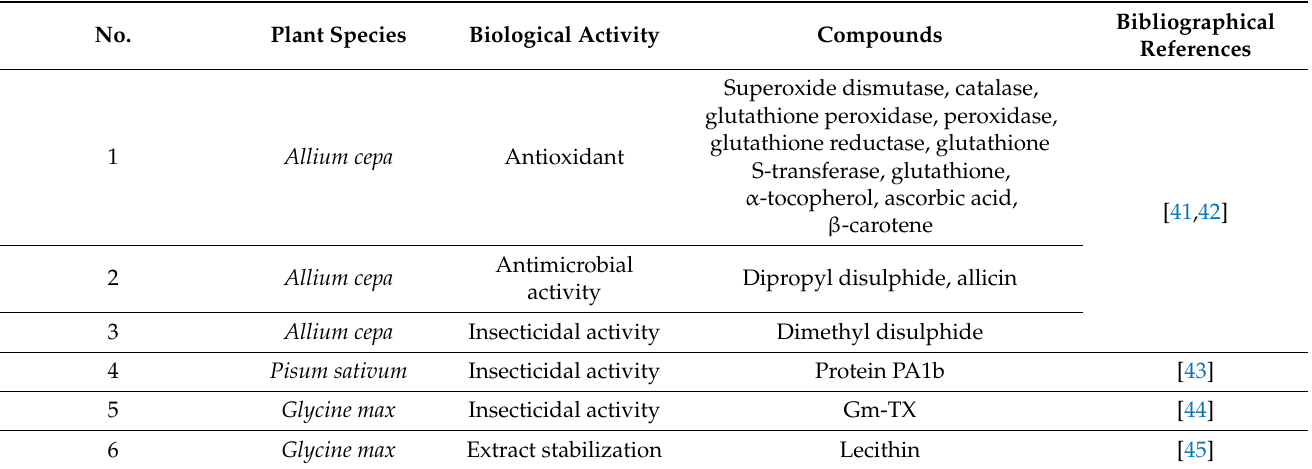
Table 1. The most important bioactive substances with a role in biostimulation, fertilization, and repellent against